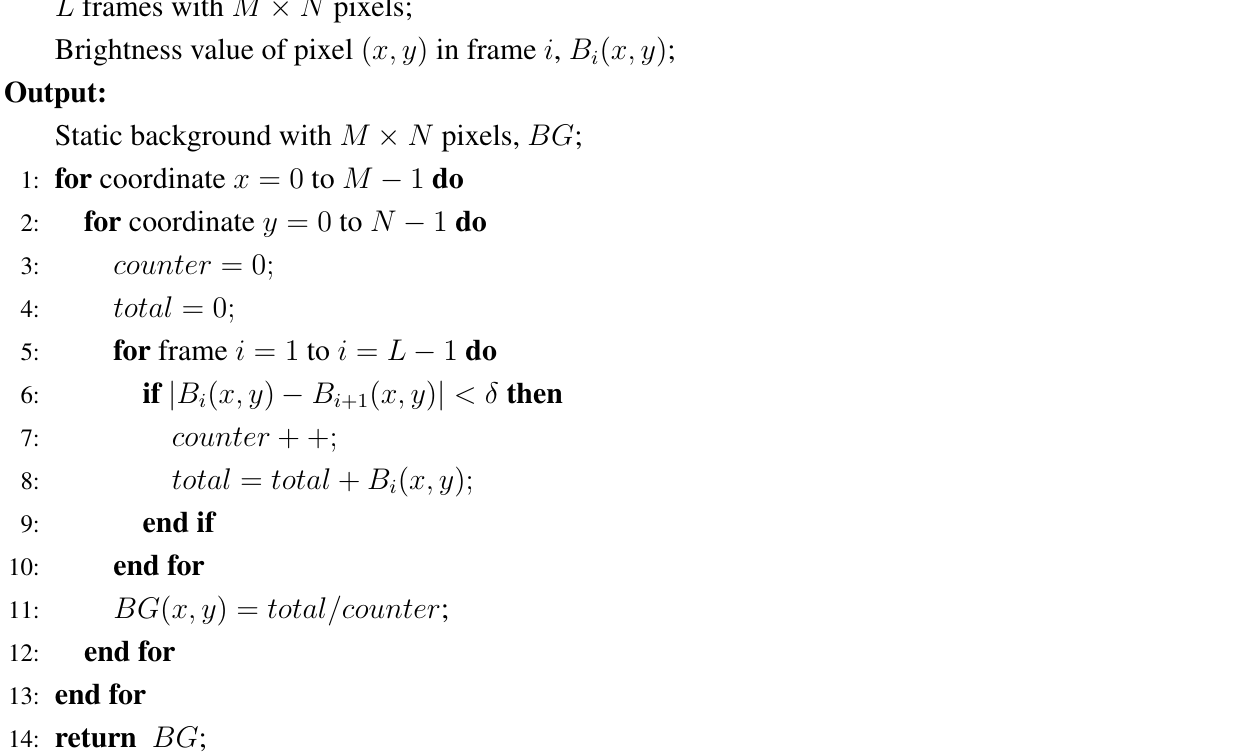
Algorithm 1. Static background gained from a sequence of